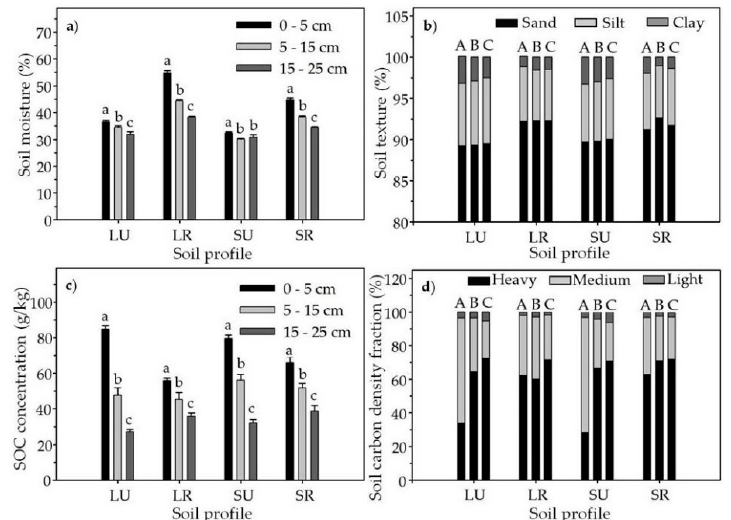
Figure 3. Soil moisture ( a ), texture ( b ), soil organic carbon (SOC) concentration ( c ) and soil carbon density fraction ( d ) of the top 25 cm soil layers in the four soil profiles (LU, LR, SU and SR) in a montane subtropical moist forest of southwestern China. Same lowercase letters (a, b and c) in ( a , c ) indicate no significant di ff erence among three di ff erent soil layers in the same soil profile; Uppercase letters (A, B and C) in ( b , d ) represent di ff erent soil layers in each soil profile (A: 0–5 cm; B: 5–15 cm; and C: 15–25 cm). Error bars indicate one standard error.